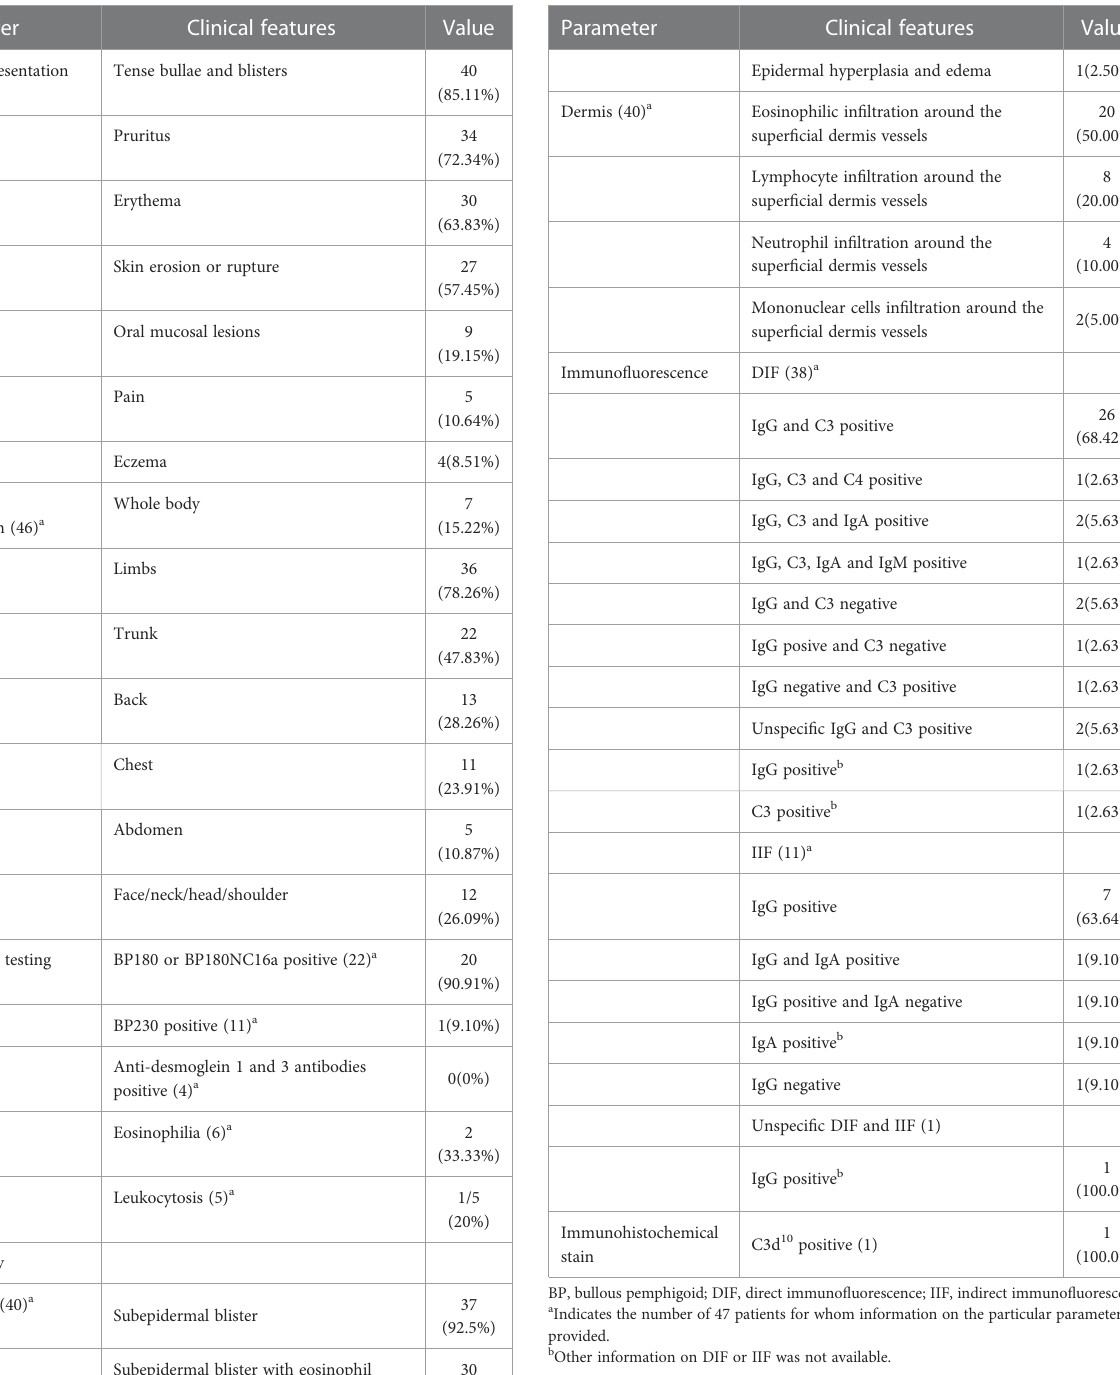
TABLE 2 Clinical information on the 47 included